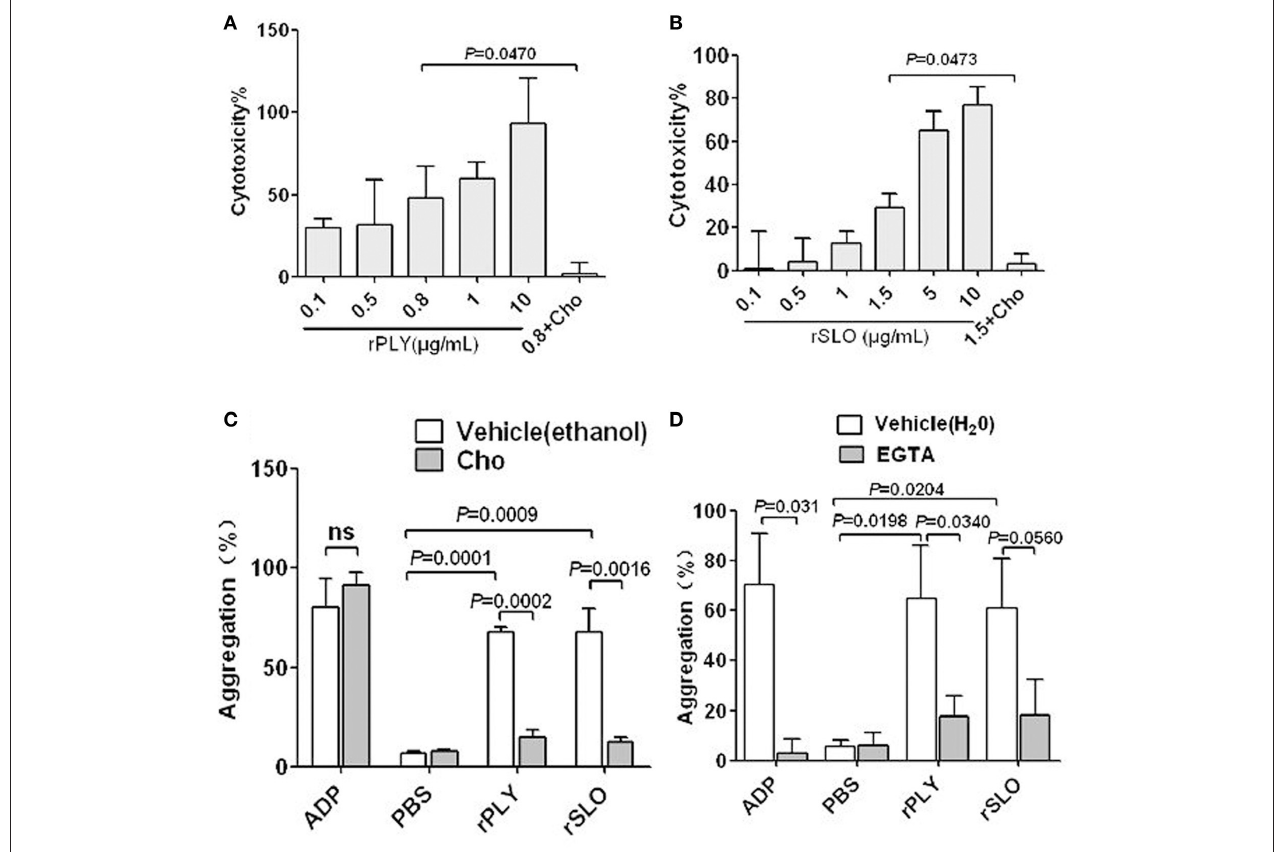
FIGURE 7 | rPLY and rSLO induce platelet aggregation via pore dependent calcium influx. The cytotoxicity of rPLY (A) and rSLO (B) against platelets and the cholesterol inhibiting effect were assessed by an LDH assay (Methods Section). (C) The cholesterol (100 µ g/mL) effect on rPLY (0.8 µ g/mL)- and rSLO (1.5 µ g/mL)-induced platelet aggregation. (D) The EGTA (3 mM) effect on rPLY (0.8 µ g/mL)- and rSLO (1.5 µ g/mL)-induced PNA formation. PBS acted as the negative control for the recombinant proteins. Cholesterol and EGTA were dissolved in ethanol and H 2 O, respectively. Unpaired t -test with Welch’s correction was used for (A,B,D) statistical analyses. Unpaired two-tailed Student’s t -test was used for (C) statistical analysis. Data in panels (A–D) are given as the mean ± SD of three independent experiments, with each experiment using blood from a different donor. P < 0.05 is considered to be the threshold for statistical significance; ns, not significant; rPLY, recombinant pneumolysin; rSLO, recombinant streptolysin O; Cho, cholesterol; 0.8 + Cho, 0.8 µ g/mL of rPLY added to cholesterol; 1.5 + Cho, 1.5 µ g/mL of rSLO added to